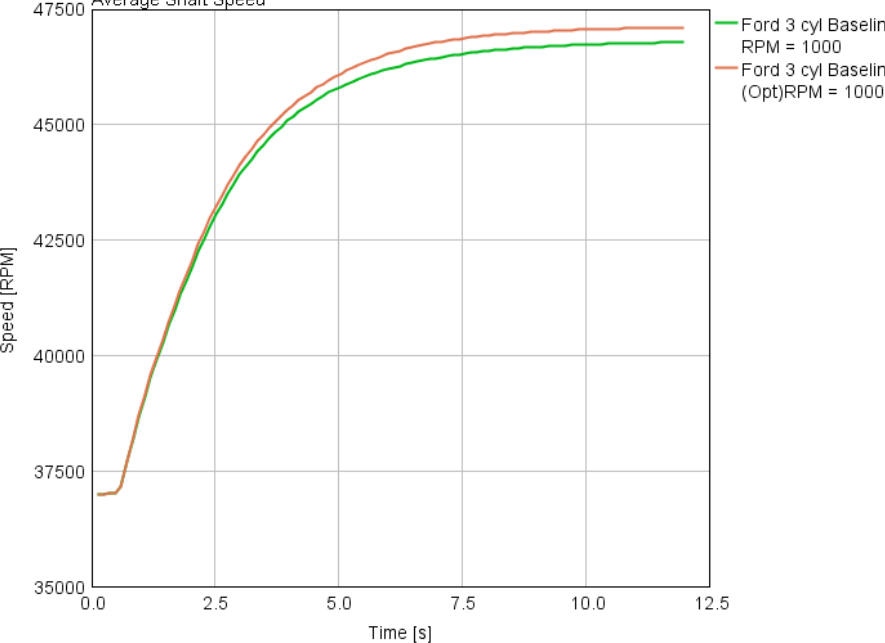
Figure 18. A verage Shaft speed of the baseline models at 1000 rpm engine speed. Figure 18. Average Shaft speed of the baseline models at 1000 rpm engine speed.